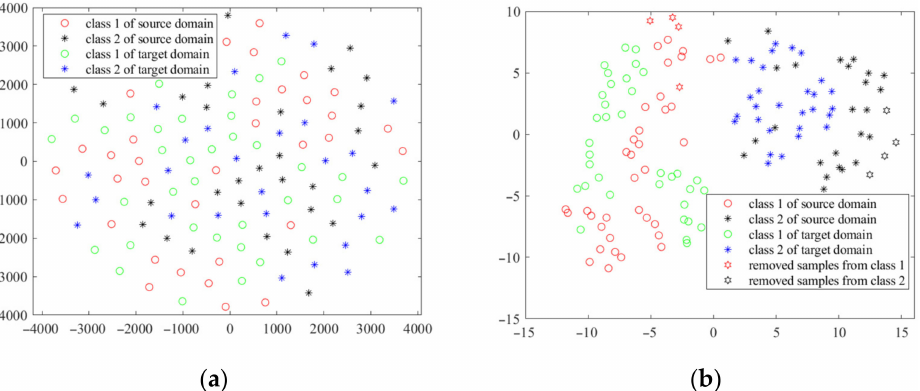
Figure 10. Visualization of original and transferred features from source domain and target domain. ( a ) Visualization of original features from source domain and target domain; ( b ) visualization of transferred features from source domain and target